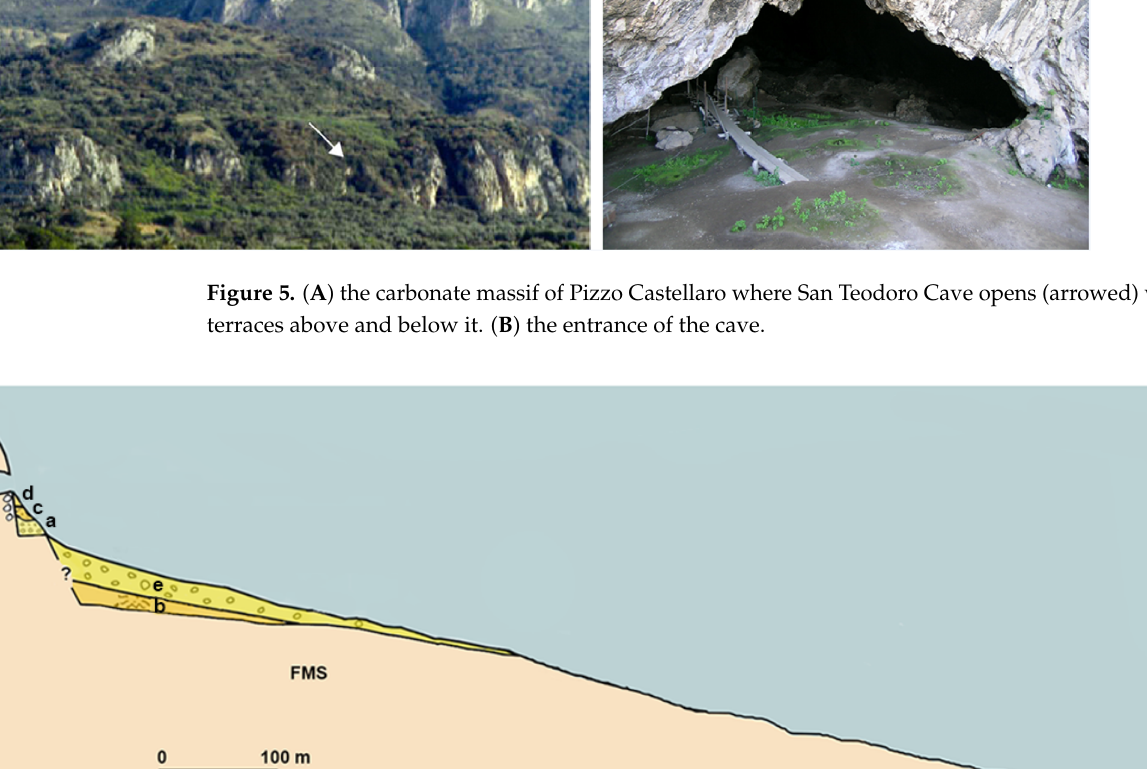
Figure 6. Schematic profile of the Pizzo Castellaro cliff with the San Teodoro Cave (G), the marine abrasion platforms at 130 m and 60–100 m (referred to the MIS 5e), and the terrace at 25–30 m a.s.l. JL: Jurassic limestone; FMS: Monte Soro Flysch. a: beach deposits. b: “PO” fossiliferous deposits